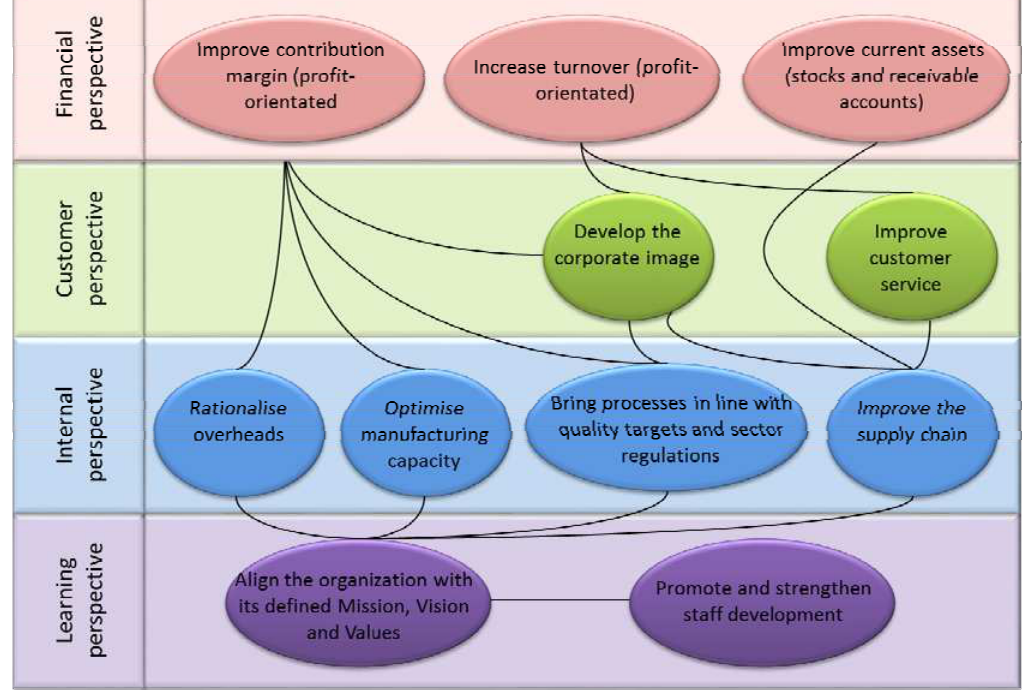
Fig. 2. BSC of Company